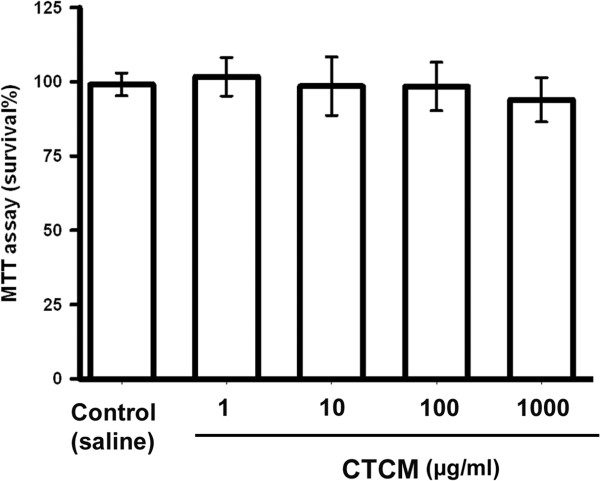
Cytotoxic effect of the CTCM in P815 cells. Various concentrations of CTCM (1, 10, 100 and 1000 μg/ml) were incubated with P815 mast cells for 9 hr. The cell viabilities were measured by MTT assay to determine the percentage of viable cells present. No significant difference between the CTCM-treated group and the control was seen (P >0.05).